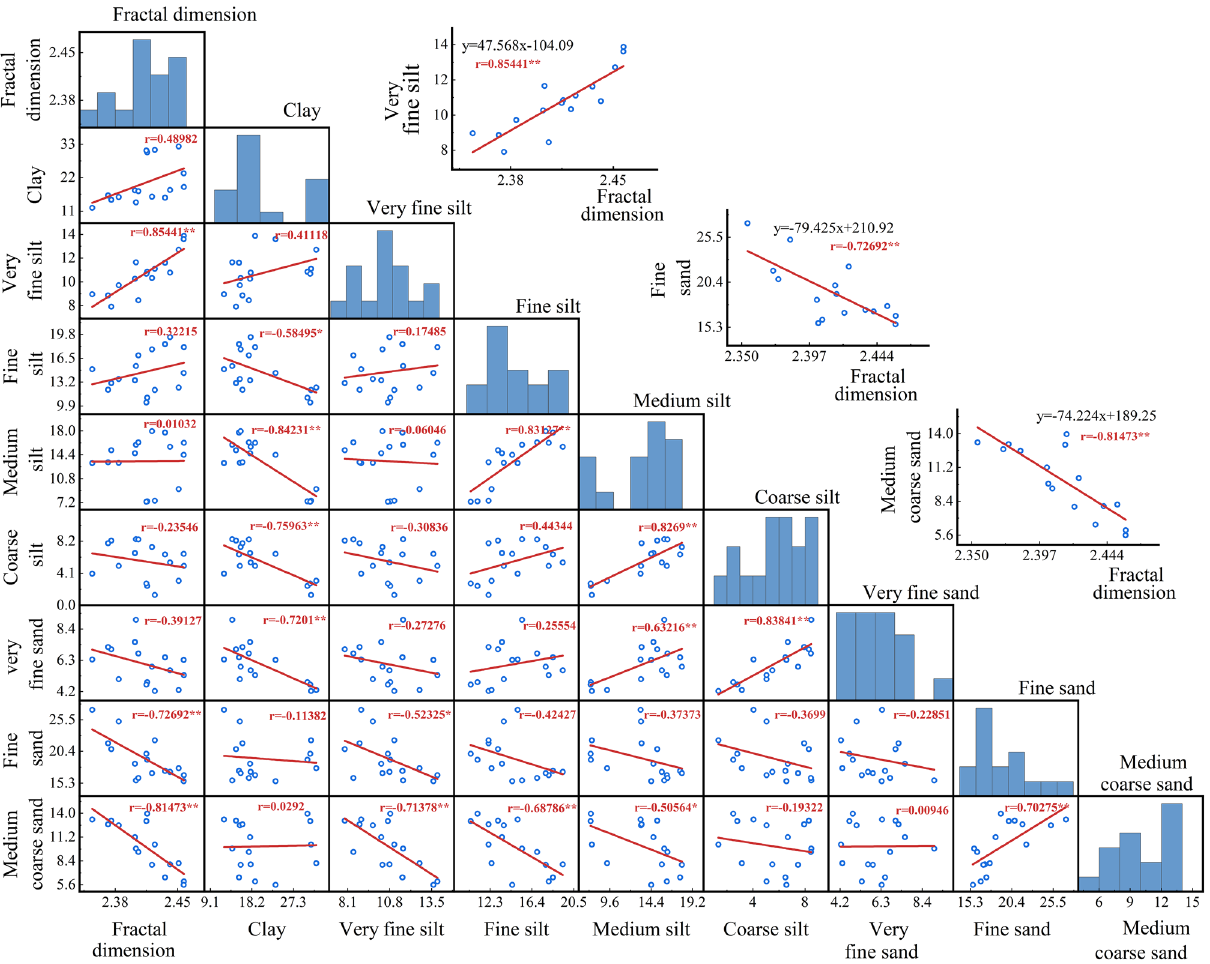
Figure 5. The correlation between fractal dimension and particle size composition. (*indicates a significant difference at the P < 0.05 level, ** indicates a highly significant difference at the P < 0.01